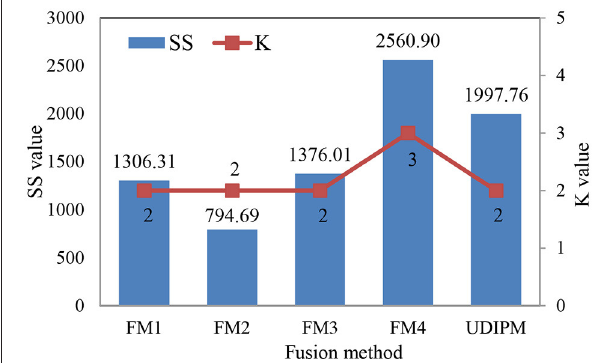
FIGURE 13 | Similarity measure and clustering results of different fusion methods.